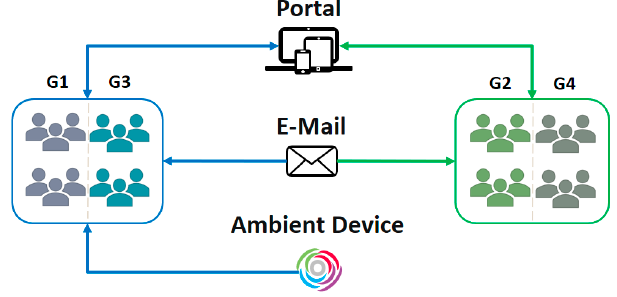
Figure 3. Channels through which feedback was provided during the test